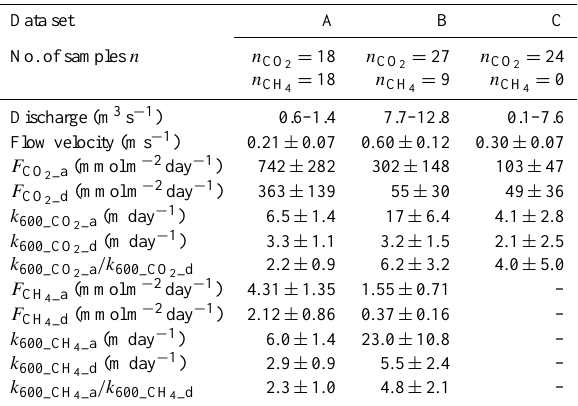
Table 2. Discharge rate, flow velocities, gas fluxes ( F CO and gas exchange velocities ( k 600_CO drifting chambers (subscript d) and from anchored (subscript a) chambers during the three field campaigns (A–C, cf. Table 1). Ex- cept for discharge, all values are given as mean ± standard devia-